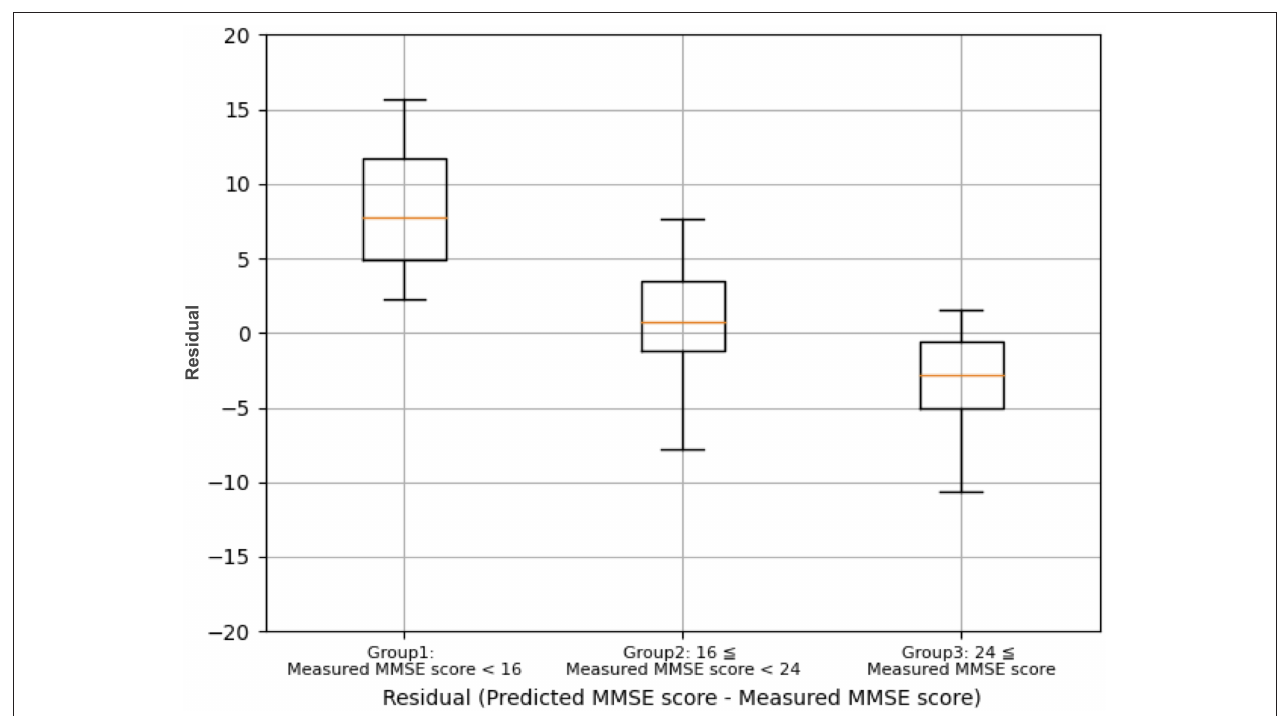
TABLE 4 | Prediction accuracy of the DNN3 in the two-class classification of MMSE ( N = 202, five-fold cross validation). Ground truth MMSE Predicted MMSE Accuracy ≥ 24 < 24 ≥ 24 69 0 Specificity: 100% < 24 15 118 Sensitivity: